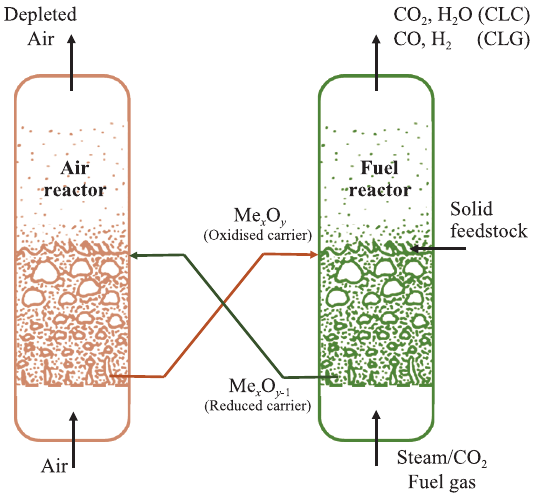
Fig. 5 Concept of chemical looping in fluidised beds